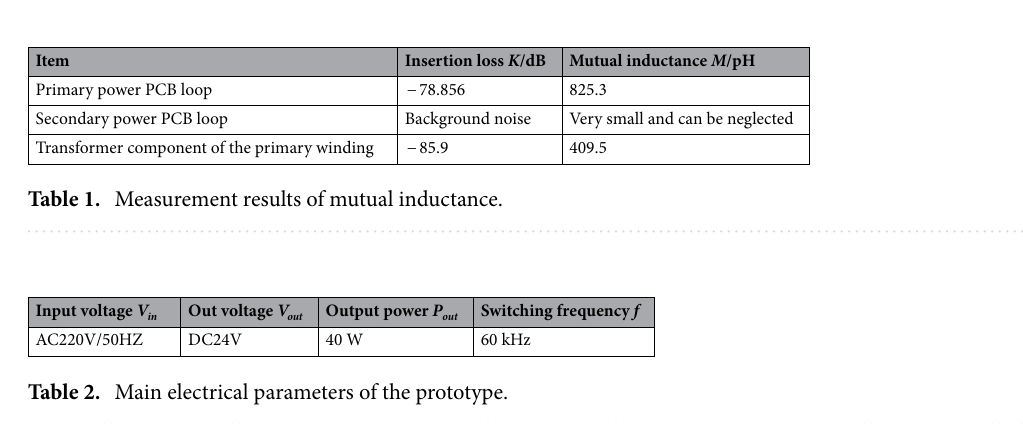
Figure 28. Insertion loss K curve between the primary power PCB loop and the plug loop.